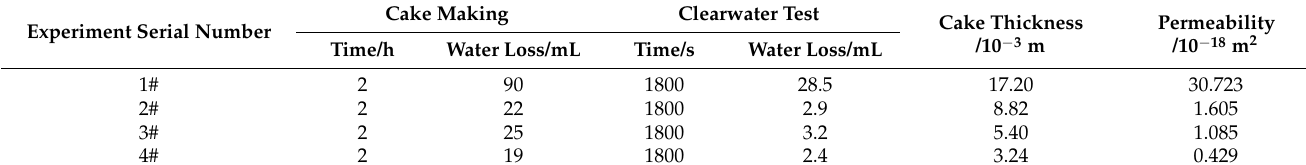
Table 2. Performance of filter cake under different compound barite conditions.